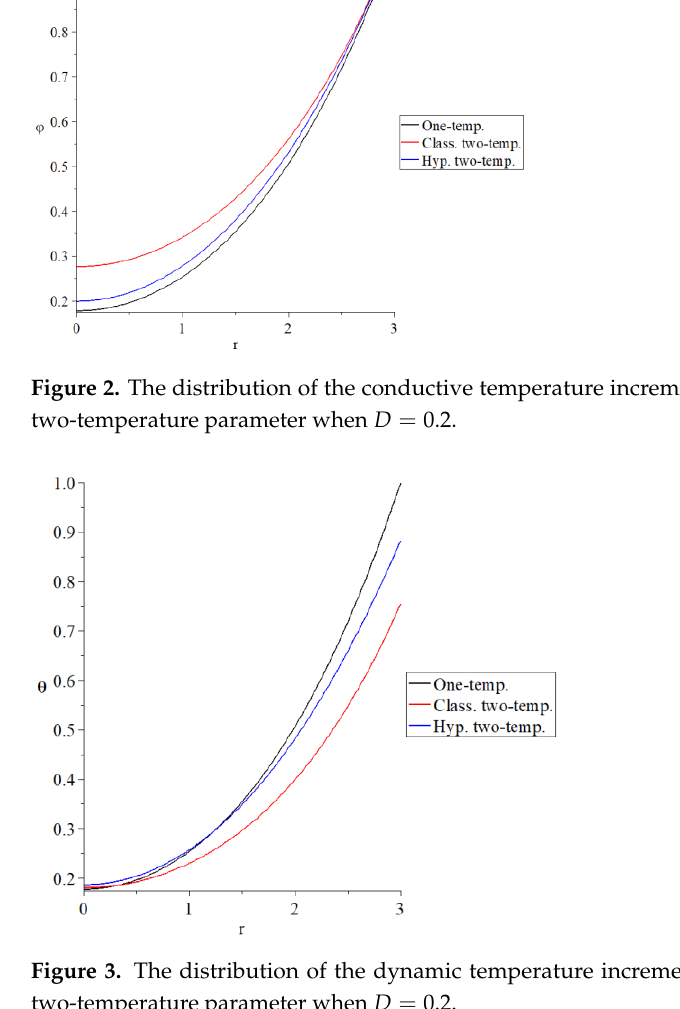
Figure 5. The distribution of the displacement for the variance values of the two-temperature pa- rameter when 0.2 D = . Figure 6. The distribution of the average stress for the variance values of the two-temperature pa- rameter when 0.2 D = .